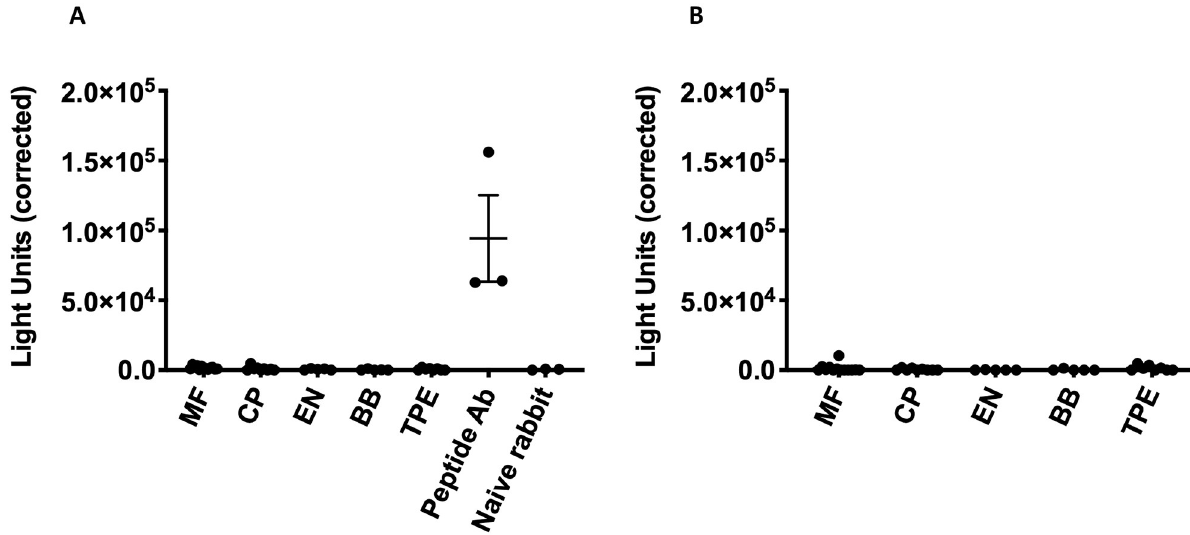
Fig 8. Serum of filaria-infected individuals does not contain detectable IgG or IgE against Bm-UGT. Filarial patient serum was incubated with a Bm-UGT-luciferase fusion protein. No detectable (A) IgG and (B) IgE was measured using the LIPS assay. The Bm-UGT peptide rabbit polyclonal antibodies served as a positive control for the detection of IgG. MF = microfilaremic, CP = chronic pathology, EN = endemic normal, BB = blood bank donors, TPE = tropical pulmonary eosinophilic, and Peptide Ab = Bm-UGT peptide polyclonal antibodies.